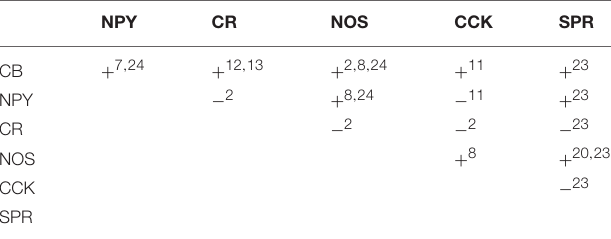
TABLE 3 | Co-expression of molecular markers in SOM